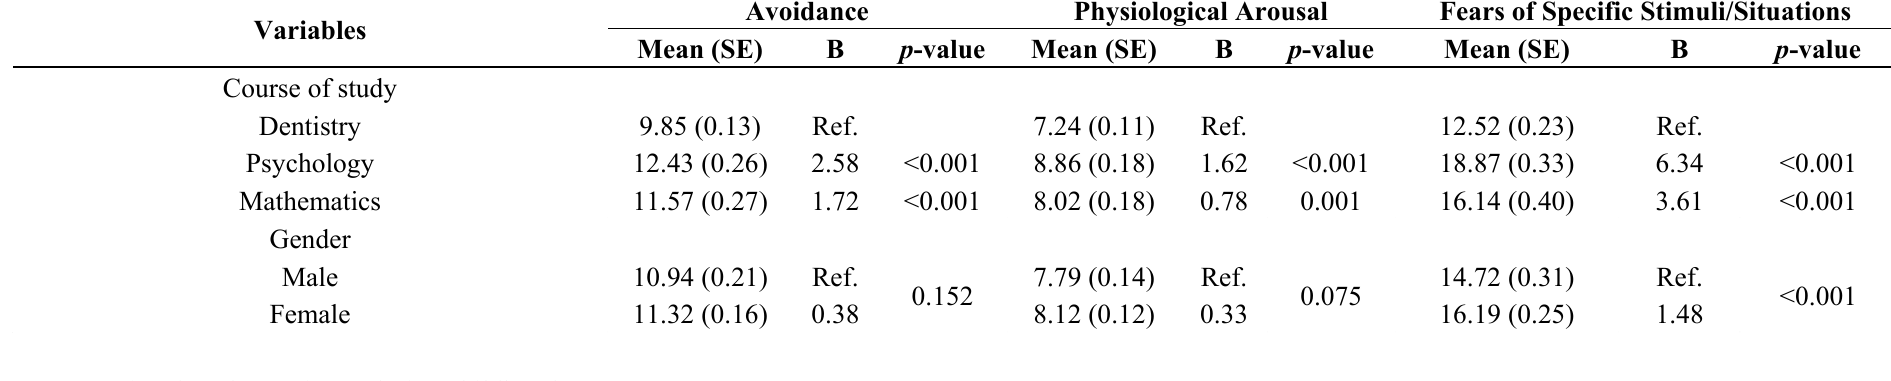
Table 2. Bivariate linear regression for each dimension of DFS according to independent variables. Avoidance Physiological Arousal Fears of Specific Stimuli/Situations Variables Mean (SE) B p -value Mean (SE) B p -value Mean (SE) B p